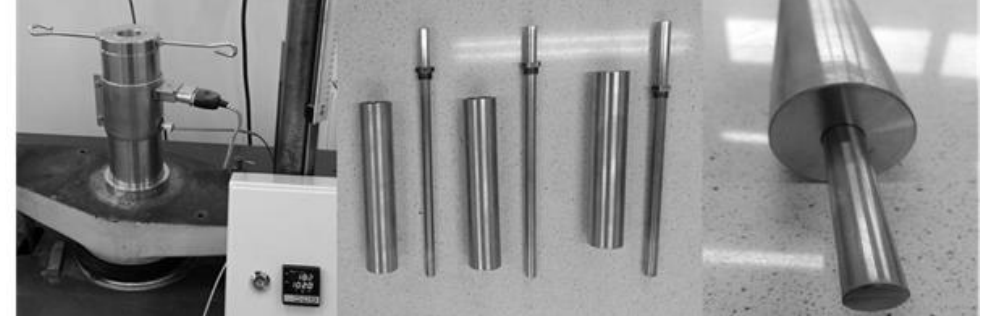
Figure 4. Laboratory-scale compaction stand for pellet production. Table 1. Compaction pressure levels with forces for different die diameters.